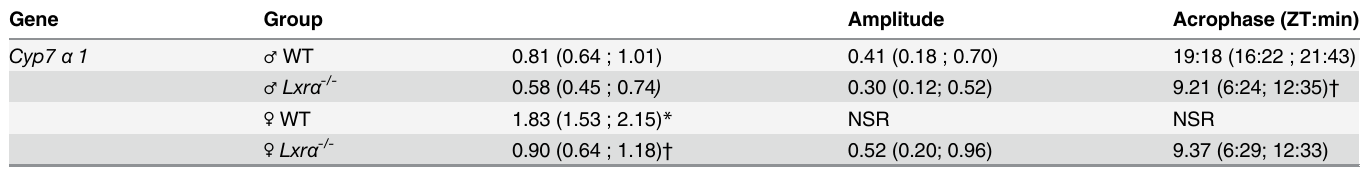
Values are represented as median ± 95% bootstrap con fi dence intervals. * indicates signi fi cant differences between females vs males † indicates signi fi cant differences between Lxr α -/- vs WT